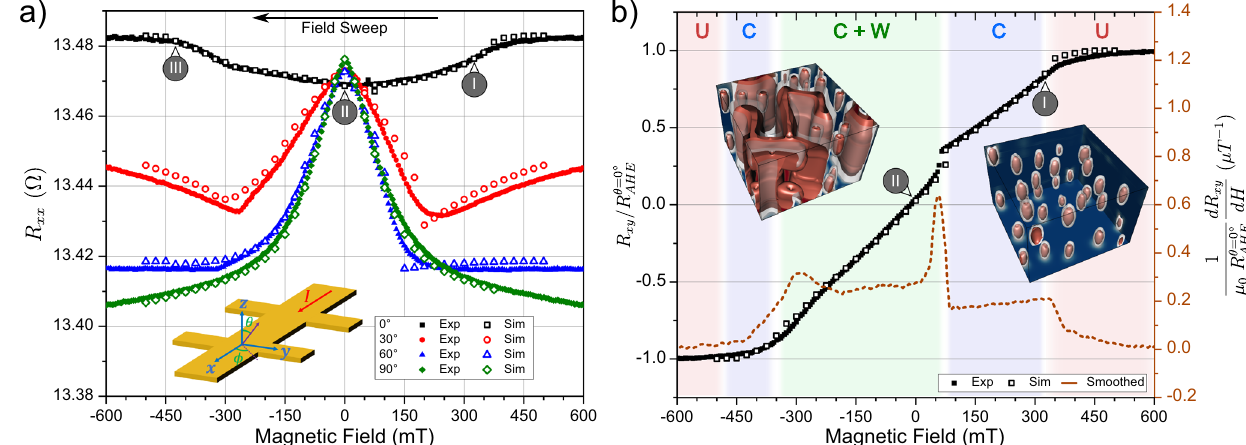
Fig. 4 | Electronic transport measurements on 20×100 μ m 2 Hall bars for a DG, associated with the corresponding micromagnetic simulations. a Measurements of R xx ( H ) for different inclinations ofthe magnetic fi eld. The inset shows the geometry of the experiment. b R xy ( H ) at θ =0 ∘ (OOP fi eld) and its deri- vative. The background colorscorrespondsto the magnetic phases (U: uniform, C: cocoons,W:worms)aspredictedbythesimulations.Thedisplayedsimulationsare